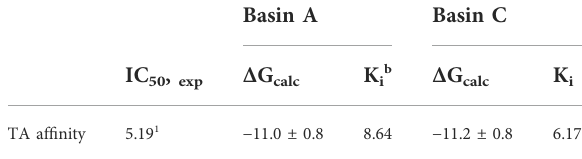
TABLE 1 Af fi nity and binding free energy of TA against TyrR were obtained from FM simulation and compared with available experimentaldata.Thebindingfreeenergiesandthebindingaf fi nities are calculated for basins A and C.